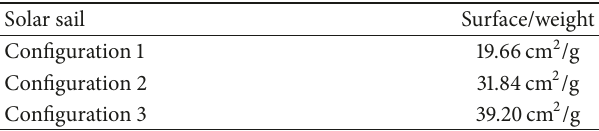
Table3:Exampleofsurface/weightratiofordifferentconfigurations of the solar